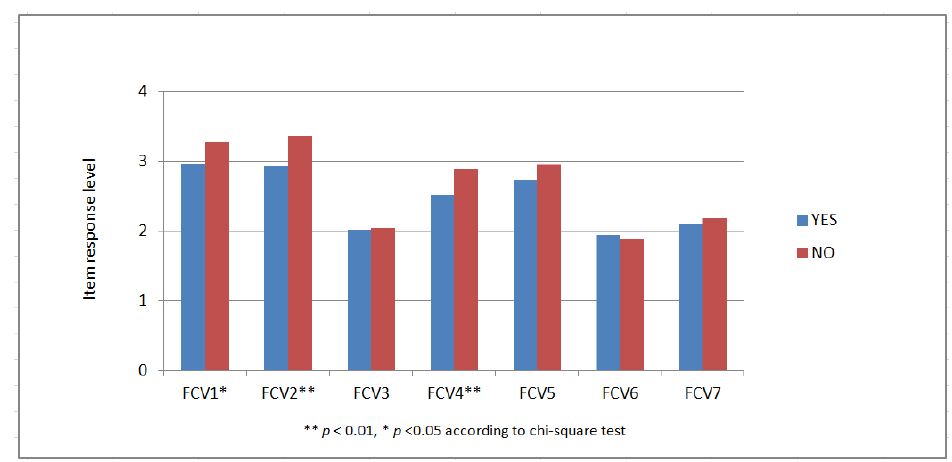
Figure 1. Distribution of FCV-19s responses by vaccination status.